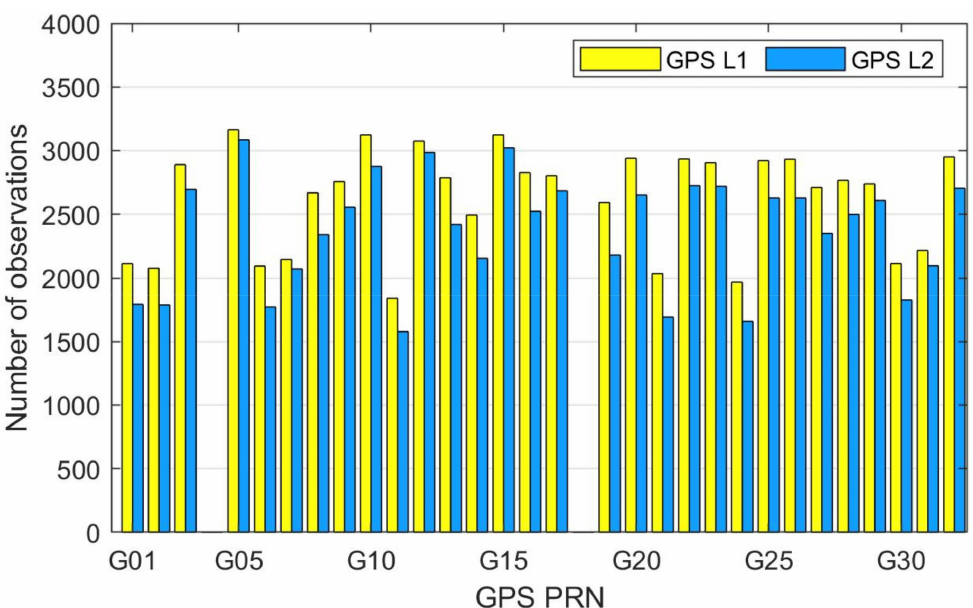
Figure 1. The number of observations for Global Positioning System (GPS) satellites.